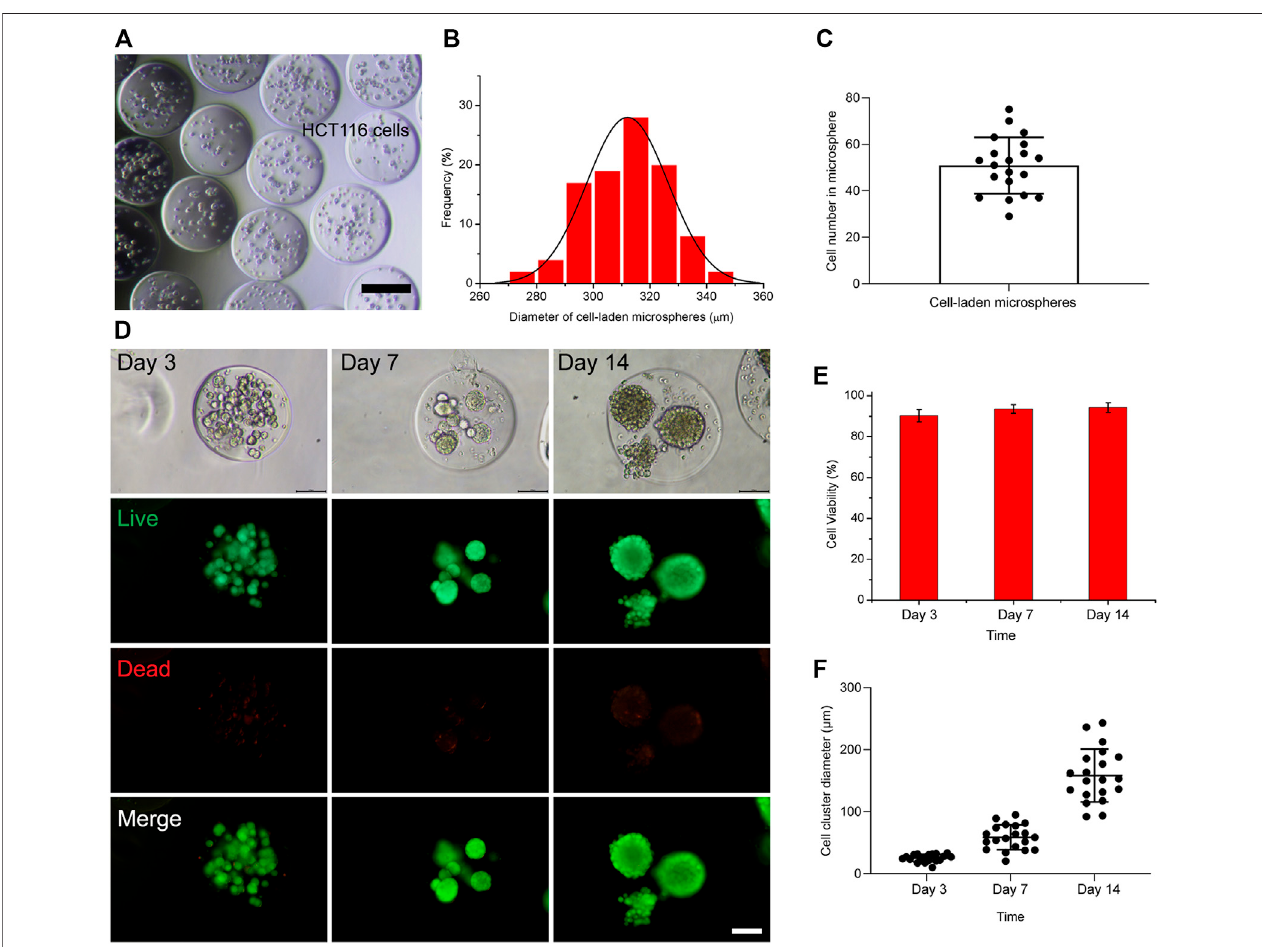
FIGURE4| Generationofcell-ladenhydrogelmicrospheresinthemicro fl uidicsystem. (A) Representativeimageofcell-ladenhydrogelmicrospheres.Thescalebar represents 200 µm. (B) Size distribution of cell-laden hydrogel microspheres. (C) The number of cell-encapsulated in the hydrogel microspheres. (D) Fluorescence microscopy image of HCT116-laden hydrogel microspheres after culturing for 3, 7, and 14 days. The scale bar represents 100 µm. (E) Percentage viability of encapsulatedcellsinthehydrogelmicrospheresof3,7,and14 days. (F) Thediameterofthecellspheroidsformedwithinthehydrogelmicrospheresafterculturing for 3, 7, and 14